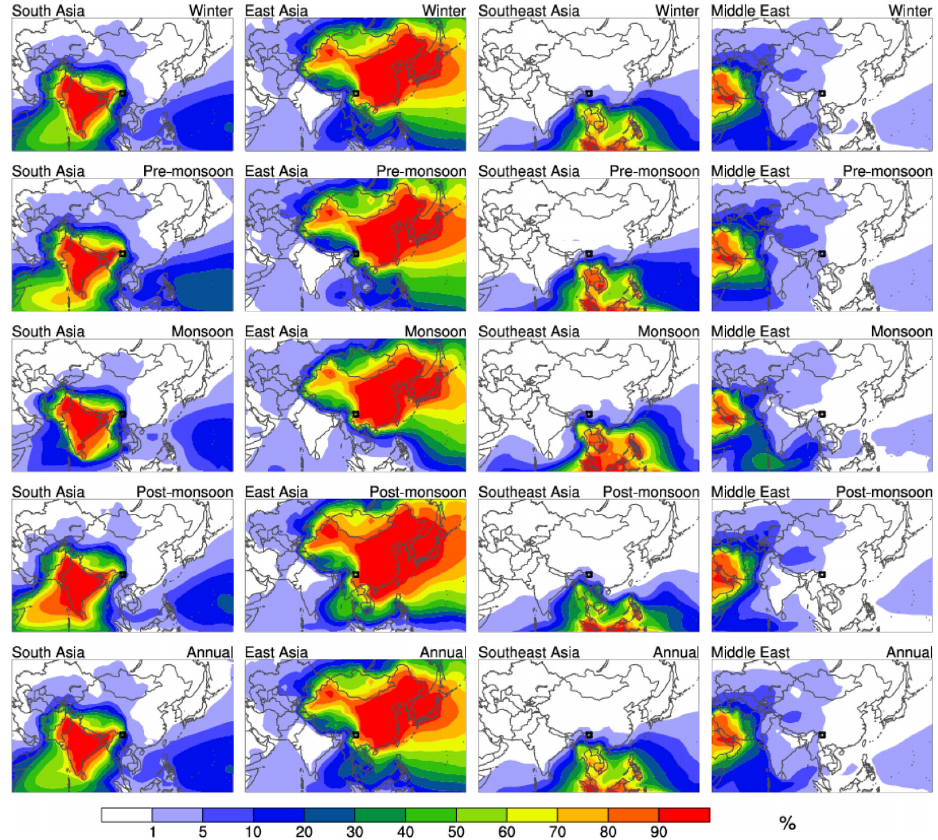
Figure 14. Annual and seasonal (winter, pre-monsoon, monsoon, and post-monsoon) mean relative contributions of emissions in four tagged source regions, including South Asia, East Asia, Southeast Asia, and the Middle East, to near-surface BC concentrations. The black box in each panel marks the grid box where the Yulong and GHZ sites are